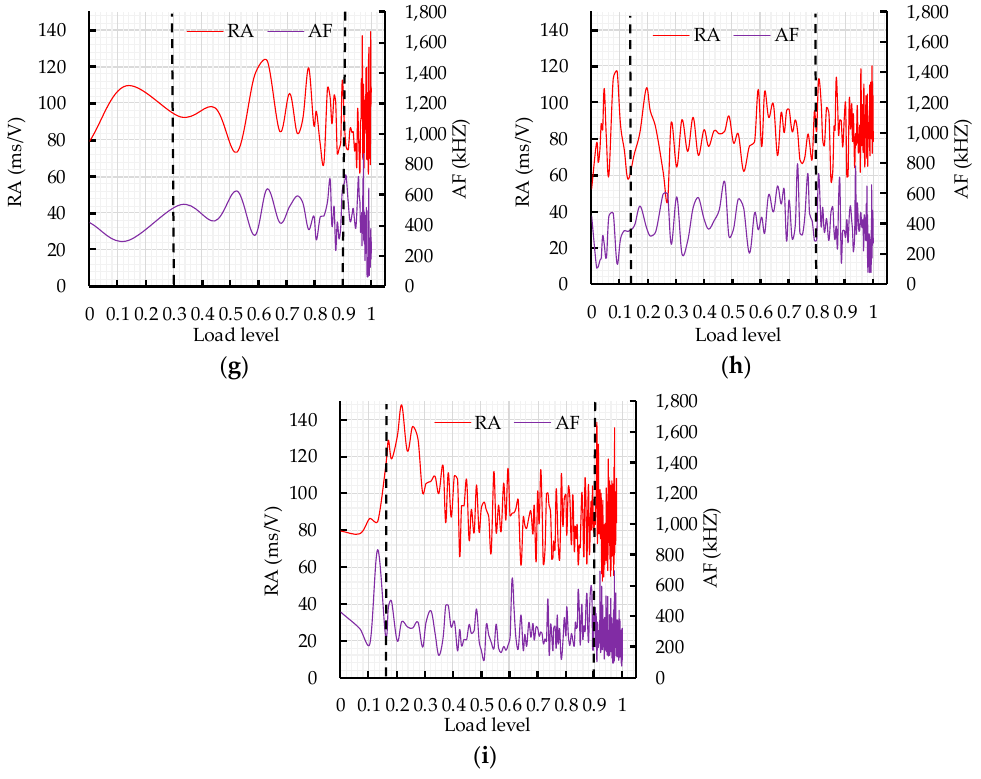
Figure 10. The curve of the RA and AF values versus load level l: ( a ) A1; ( b ) A2; ( c ) A3; ( d ) A4; ( e ) A5; ( f ) A6; ( g ) A7; ( h ) A8; ( i ) A9.